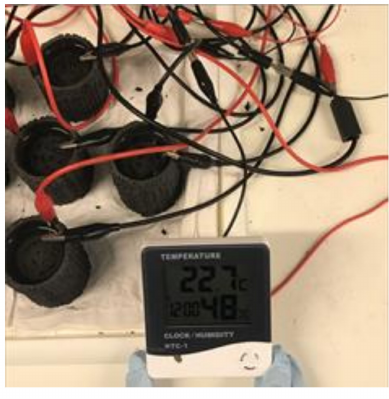
Figure 3. Demonstration of powering a digital weather station with additive manufacturing (AM)-built